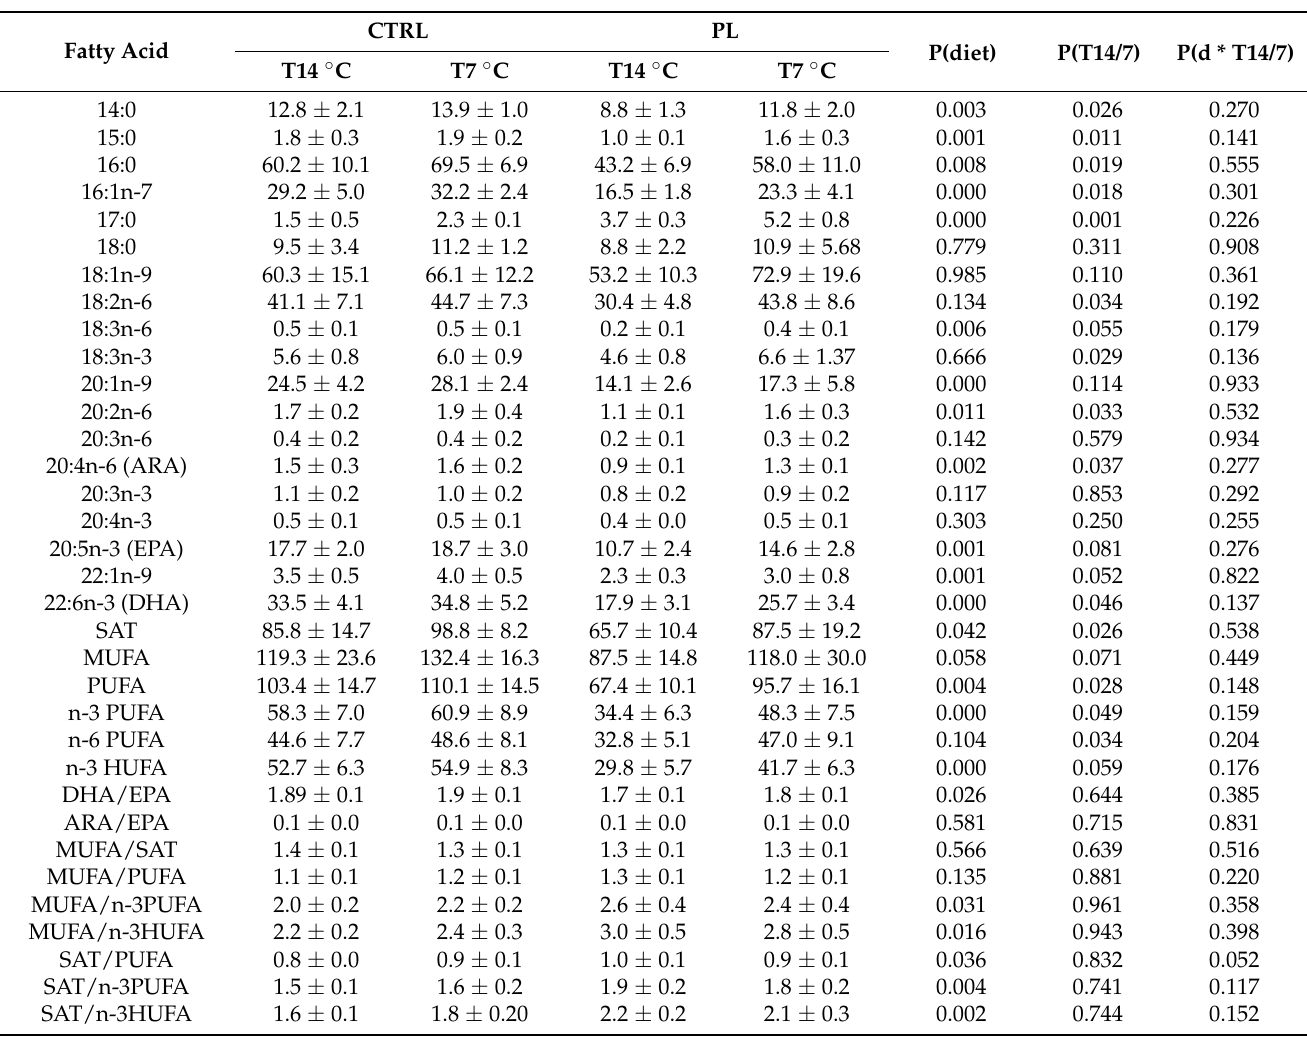
Table 4. FA composition ( µ g mg dw − 1 ) in liver of meagre fed with CTRL and PL-enriched diets and kept at 14 ◦ C (T14 ◦ C) or challenged at 7 ◦ C (T7 ◦ C) (mean ± SD, n = 4).